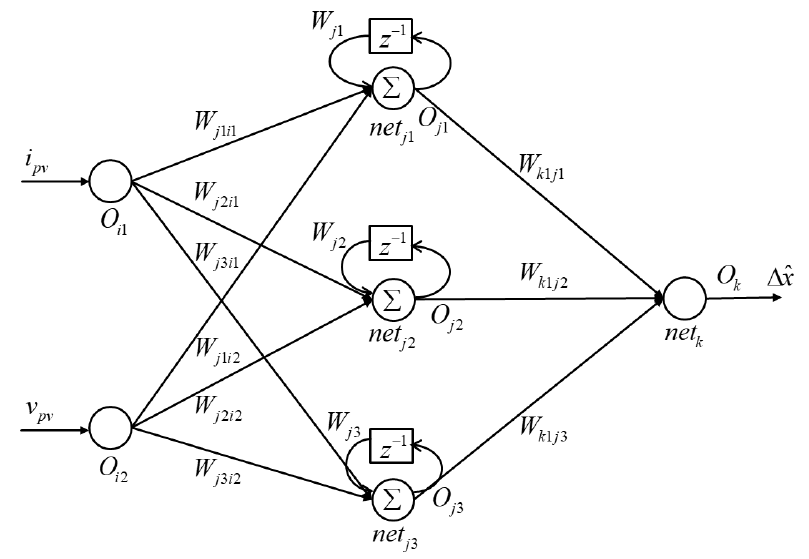
Figure 3. The structure of the proposed controller of a PV system based on a neural network.